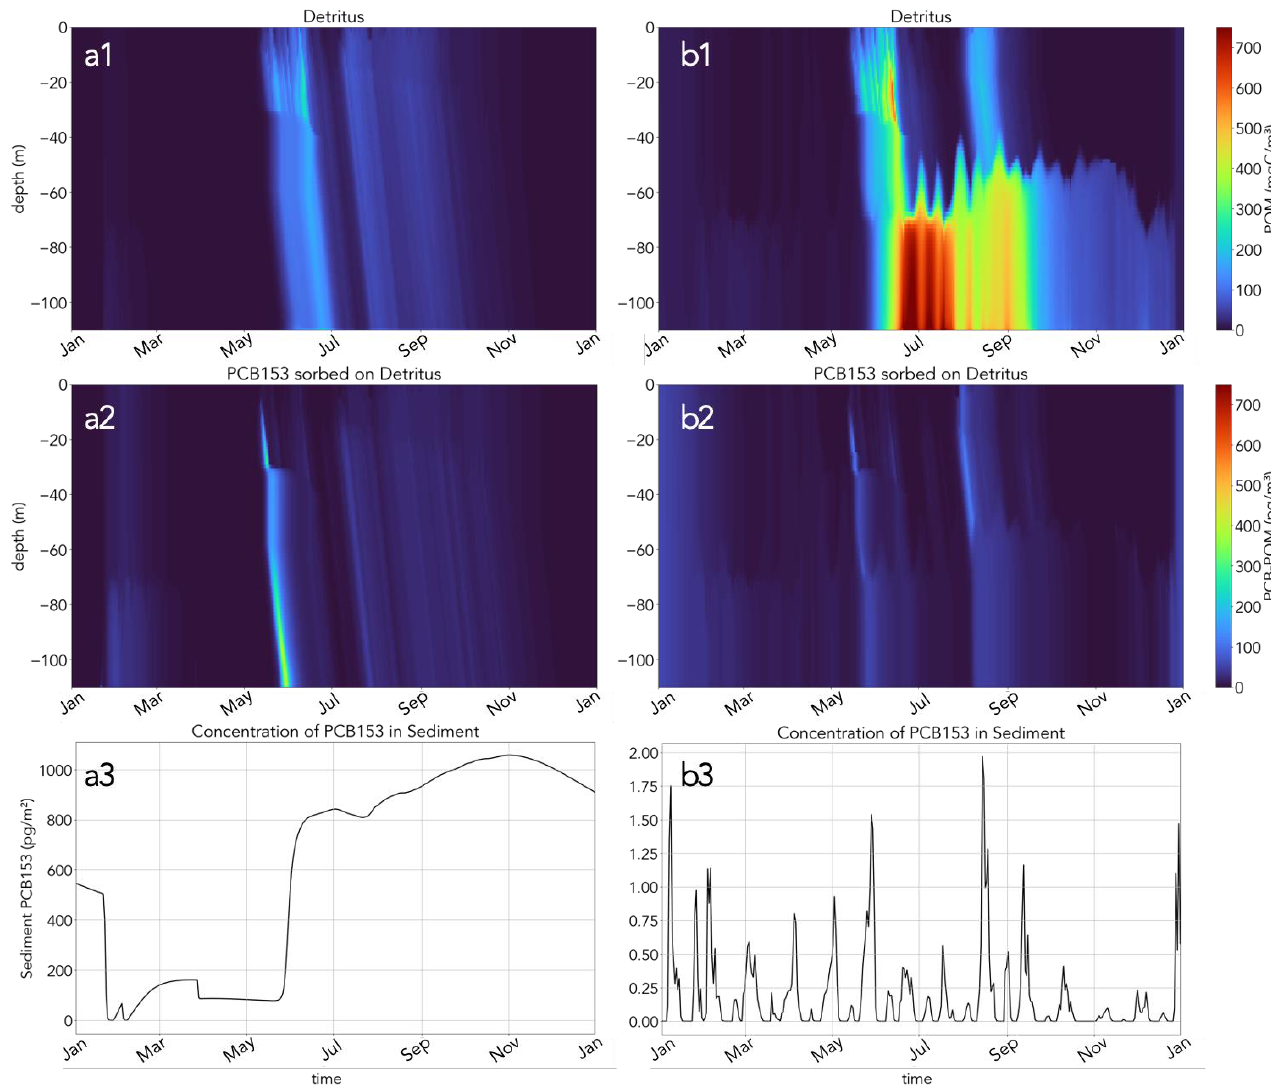
Figure 9. Results of simulations for: ( a1 , a2 , a3 ) no-tide scenario, ( b1 , b2 , b3 ) tide scenario (NNS, 2001 year). Concentrations of ( a1 , b1 ) detritus (mgC m −3 ); ( a2 , b2 ) PCB POM (pg m −3 ); and ( a3 , b3 ) PCB in sediments (pg m −2 ).